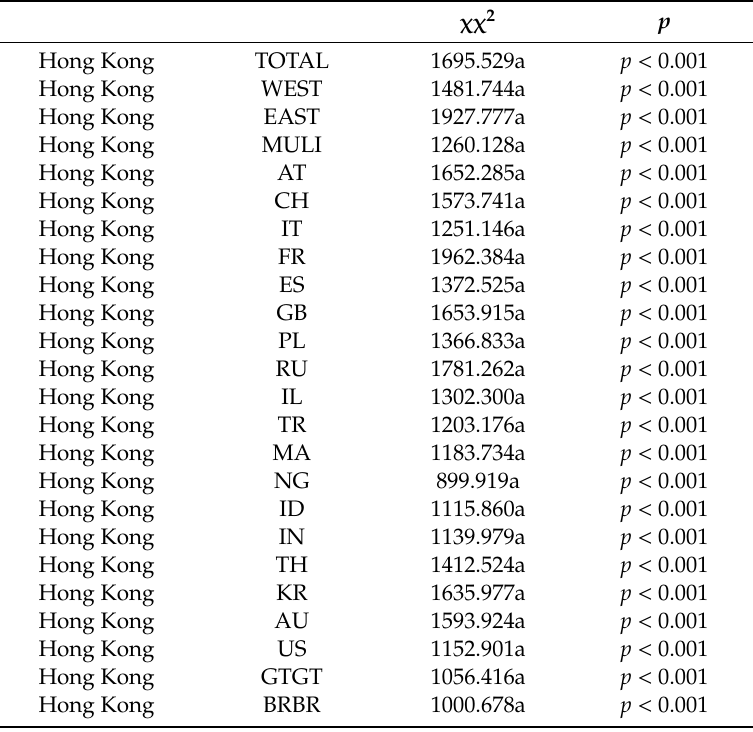
Table A10. Chi-Square test on the Numbers of Norm Values between Hong Kong and Other